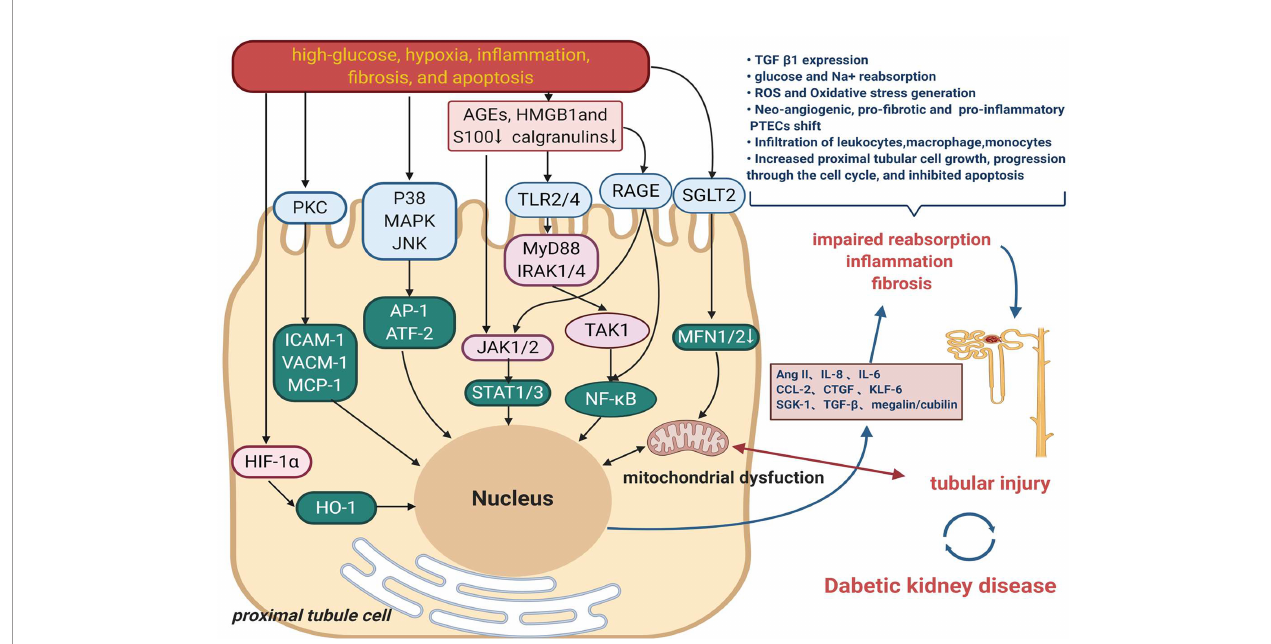
FIGURE 1 | The main mechanism of tubular damage in DKD. Diabetogenic stimuli including high-glucose, oxygen metabolic disorder, in fl ammation, fi brosis, and apoptosis result in a wide range of injured pathway such as MAPK, PKC signaling. High-mobility group box 1 (HMGB1), s100/calgranulins and advanced glycation end products (AGEs) are danger-associated molecular patterns (DAMPs) that activate cell surface pattern recognition receptors (PRRs), induce signaling events to promote the development of in fl ammation in DKD. Another mechanism that also might contribute to tubular damage is the increased renal content of HIF1- a . Multiple effects on proximal tubule ultimately result in impaired reabsorption, in fl ammation and fi brosis, which contribute to tubule injury and therefore